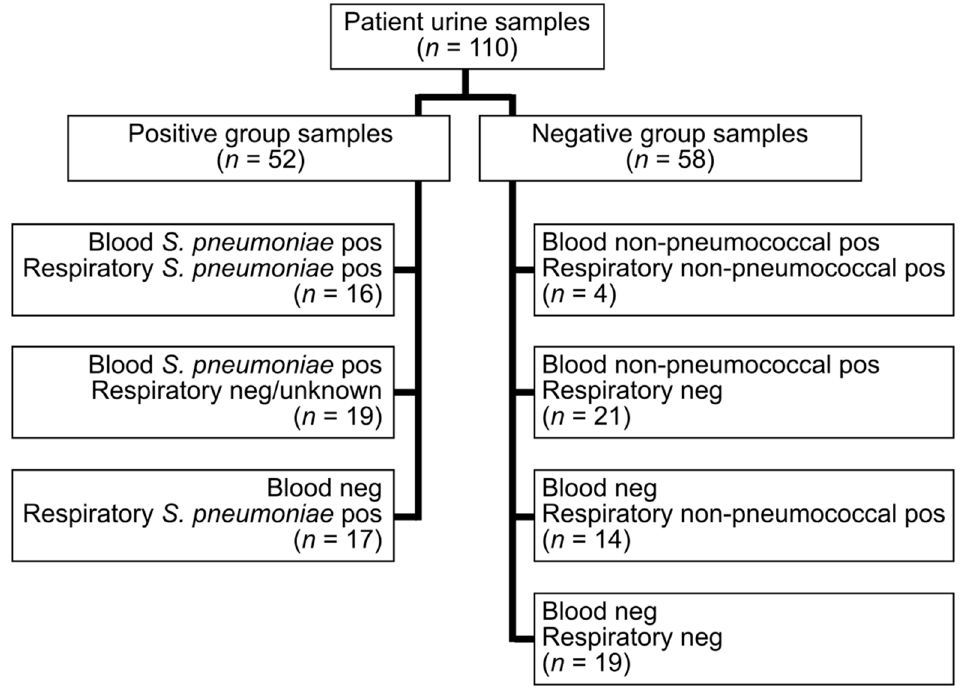
Figure 1. Blood and respiratory tract culture results for patients included in the study. Pos, positive; neg, negative. Table 2. Sensitivity of four Streptococcus pneumoniae urine antigen tests in patients with pneumococ- cal infection.